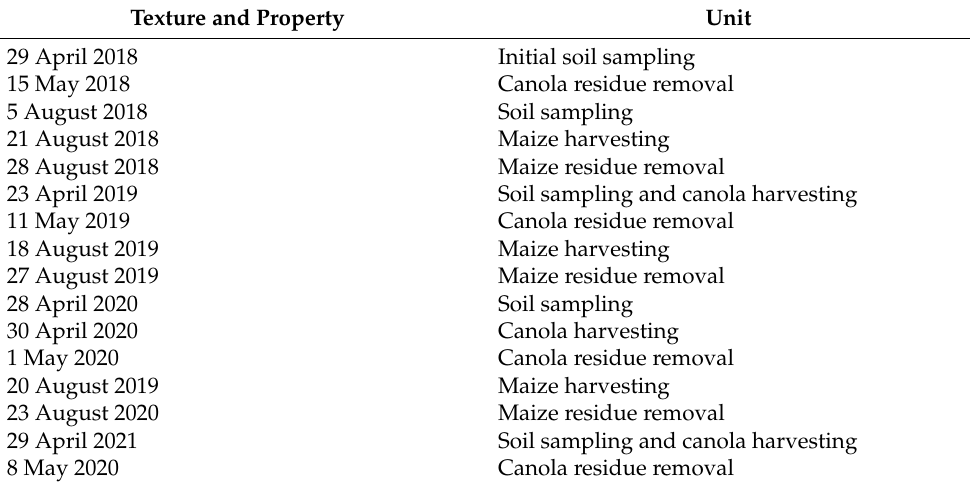
Table 2. Soil sampling and residue removal from 29 April 2018 to 8 May 2020. Texture and Property